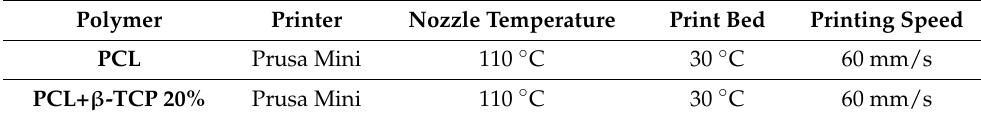
Table 1. Types of polymer and printing parameters.